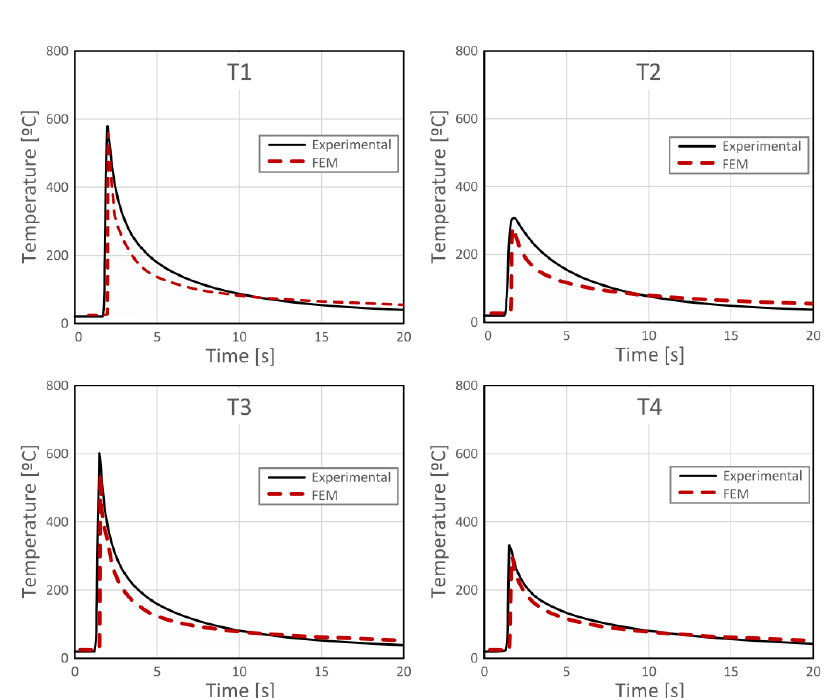
Figure 10. Temperature evolutions of the optimum case.